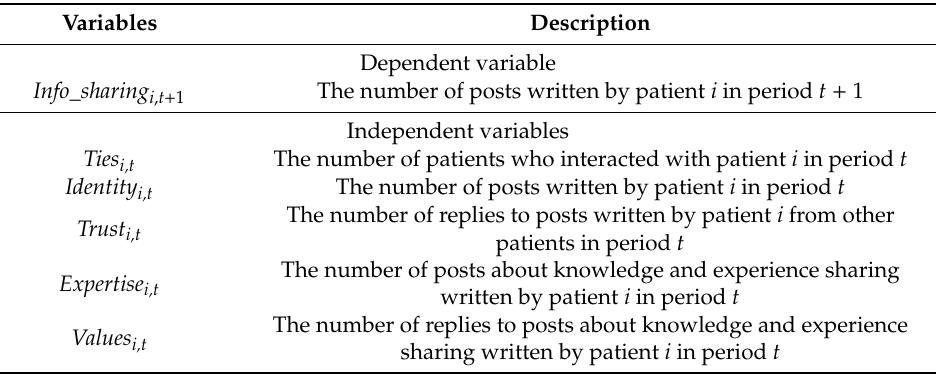
Table 1. Summary of all